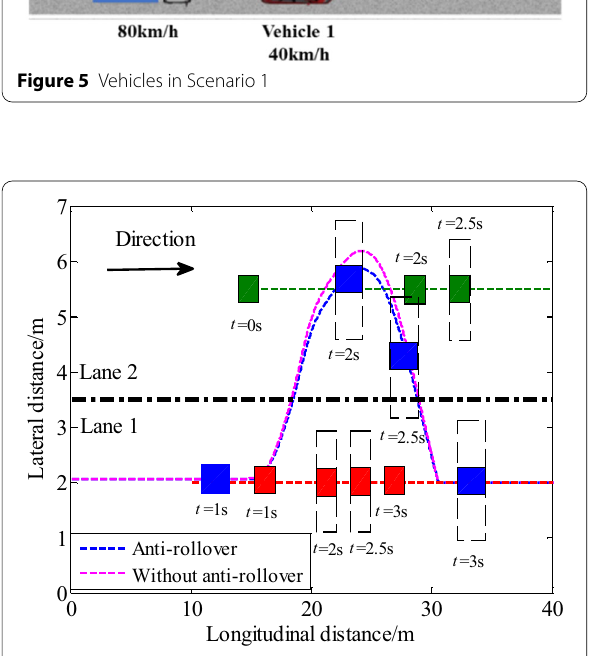
Figure 6 Vehicles’ trajectories in Scenario